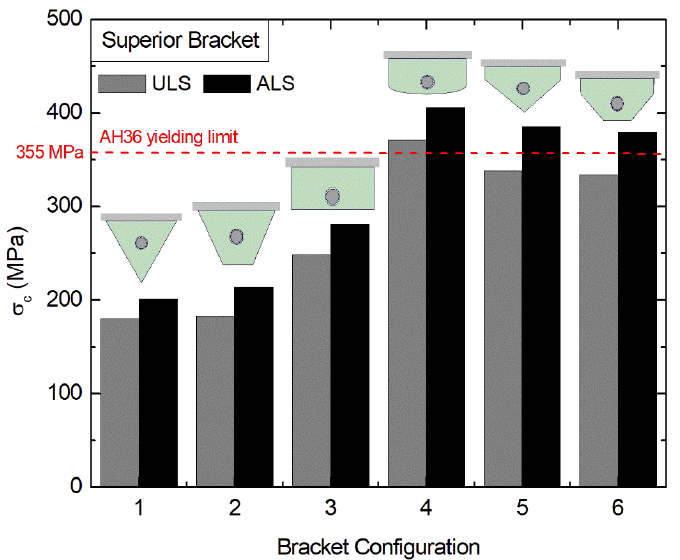
Figure 9. Maximum von Mises stress obtained in the superior bracket for the six different geometric configurations under the ULS and ALS conditions.